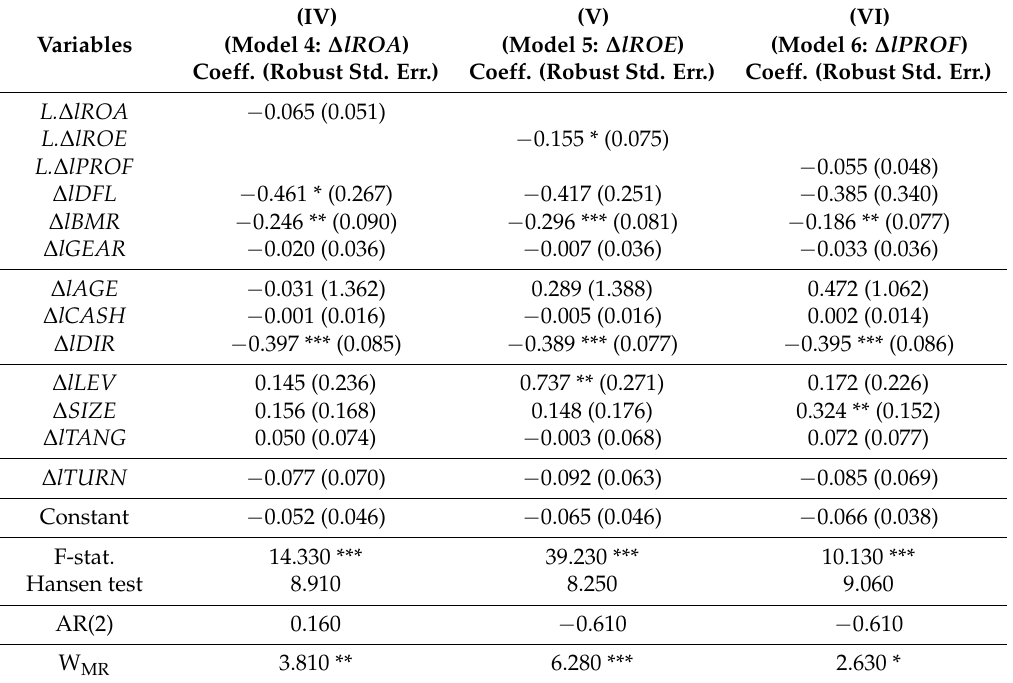
Table 8. Results of the